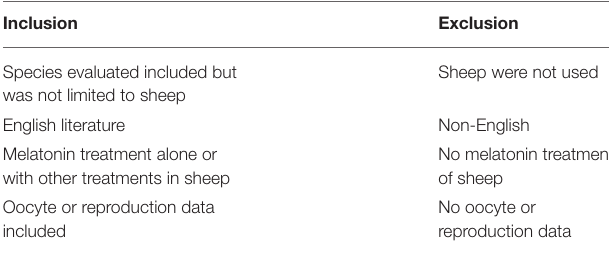
TABLE 1 | Inclusion and exclusion